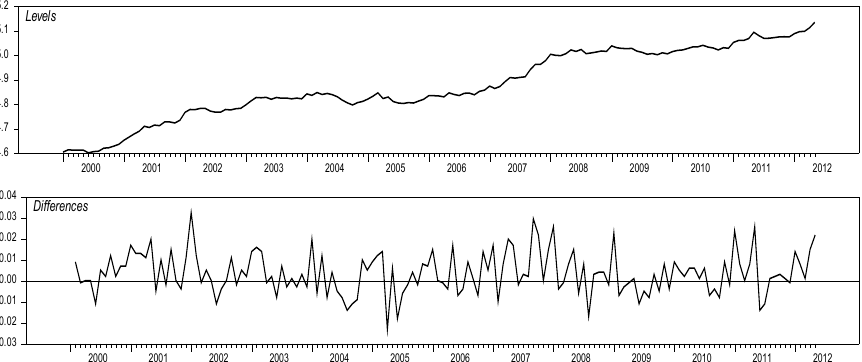
Figure 3. Price indices in the second difference. Data vector January 2000 to May 2012 (Great Depression).